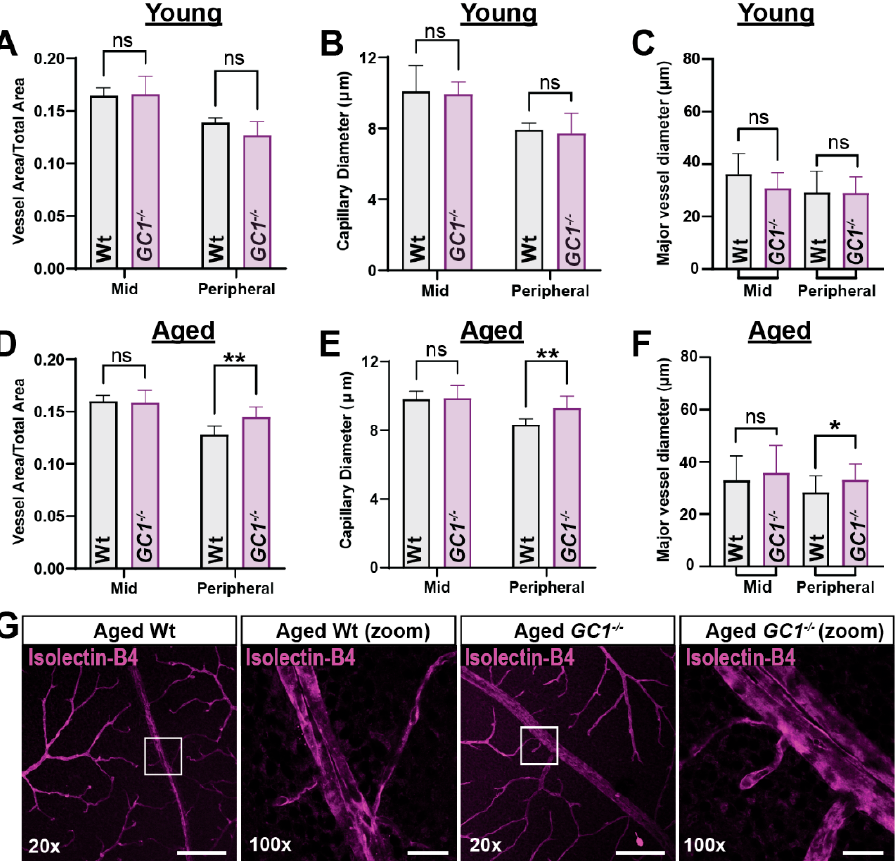
Figure 1. Aged GC1 − / − mice exhibit dilated vessel morphology in peripheral retina compared with Wt mice. ( A ) Vessel density is not significantly changed in the mid or peripheral retina of young GC1 − / − mice ( p = 0.979 and 0.307, n = 4 mice per genotype group). ( B ) Capillary diameter is not sig- nificantly changed in the mid or peripheral retina of young GC1 − / − mice ( p = 0.970 and 0.949; n = 4 mice per genotype group). ( C ) Major vessel diameters are not significantly changed in young GC1 − / − mice compared to Wt ( p = 0.45 and p > 0.99; n = 10–16; measurements from 4 to 5 mice per genotype group at mid = 1300 µm and peripheral = 2350 µm from the optic nerve head). ( D ) Vessel density is significantly increased in the peripheral retina of aged GC1 − / − mice (+12.8%; 0.128 ± 0.004 vs. 0.145 ± 0.004; ** p = 0.005, n = 7–9 mice per genotype group). ( E ) Capillary diameter is significantly increased in the peripheral retina of GC1 − / − mice (+11.5%; 9.296 ± 0.293 µm vs. 8.339 ± 0.293 µm; ** p = 0.004; n = 7–9 mice per genotype group). ( F ) Major vessels are significantly more dilated in the peripheral retina of aged GC1 − / − mice (28.360 ± 6.250 µm vs. 33.070 ± 6.100 µm; * p = 0.015; n = 19–26 measure- ments from n = 3 mice per genotype group at mid = 1300 µm and peripheral = 2350 µm from the optic nerve head). ( G ) Representative fluorescence images of whole-mount retina labeled with iso- lectin-B 4 showing dilated vessels in aged Wt and GC1 − / − mice. Scale bar = 200 µm at 20× and 25 µm at 100×. Data are presented as means ± S.D. Statistical tests performed were two-way ANOVA and Sidak’s multiple comparisons test. Each n represents one retina from one animal. In young GC1 − / − mice, total retinal vessel area and capillary diameter were unchanged in both mid and peripheral retina (Figure 1A; p = 0.979 and 0.307, and Figure 1B; p = 0.970 and peripheral regions (Figure 1C; mid p = 0.45, peripheral p > 0.99). Next, we assessed retinal vasculature in aged mice. Overall, total vessel density was unchanged in mid ret- ina, but vessel density increased in the periphery by 12.8% in GC1 − / − mice compared with age-matched Wt mice (Figure 1D; 0.128 ± 0.004 vs. 0.145 ± 0.004; ** p = 0.005). There was a significant increase (11.5%) in capillary diameter in peripheral retina of GC1 − / − mice com- pared with Wt (Figure 1E; 8.339 ± 0.293 µm vs. 9.296 ± 0.293 µm, ** p = 0.004). There was